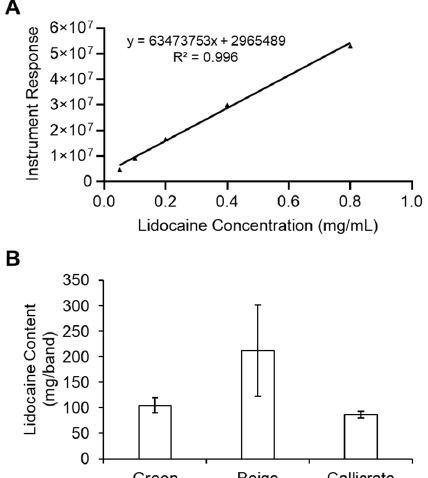
Figure 3. Calibration curve and lidocaine quantitation by GC–MS. ( A ) Standard curve for various lidocaine concentrations quantified (in duplicate) by GC–MS. ( B ) Quantitation of lidocaine extracted from each type of lidocaine-loaded castration band (LLB). Note that, for the Callicrate bands, only a section of the band (corresponding with the surface that would contact the animal’s scrotum) was analyzed. Bars represent the mean ± standard deviation for 6 (green), 3 (beige), or 4 (Callicrate) independent replicates.